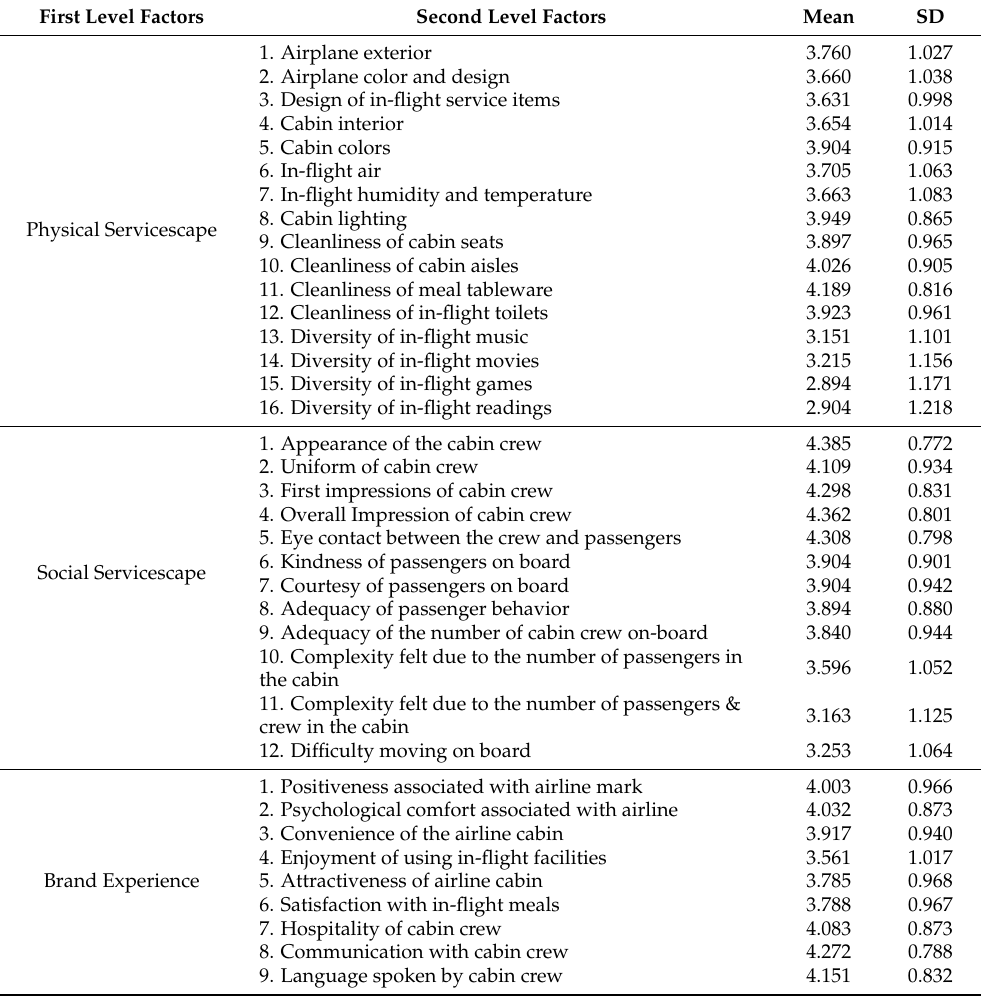
Table A1. Details of factors and their statistical